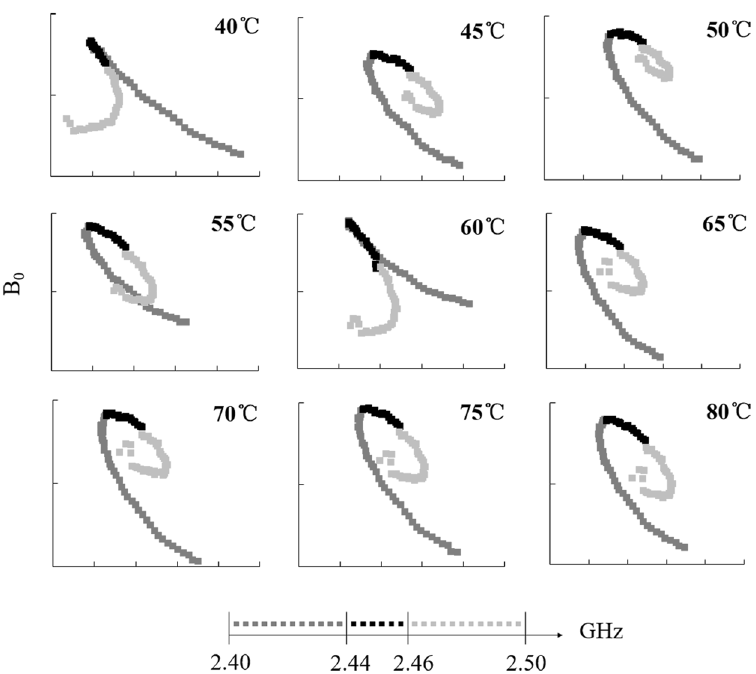
Figure 8. Change curve of starch–water mixtures B 0 ( = ε″ f B / heating.